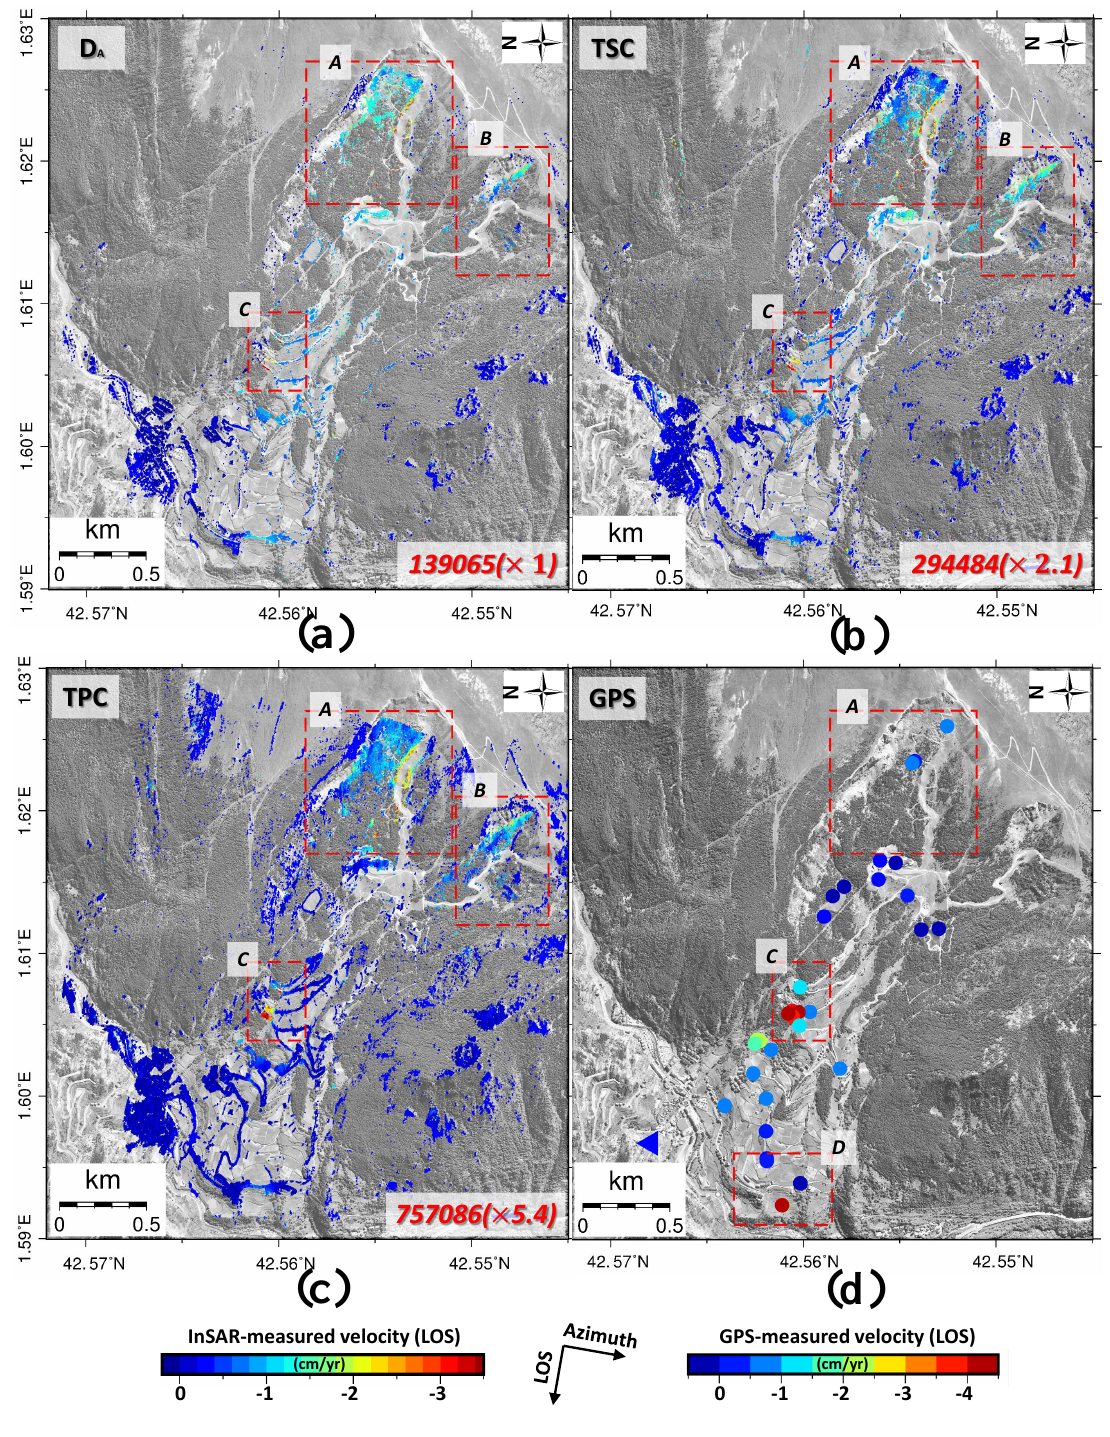
Figure 8. LOS displacement velocity maps derived by ( a ) D A , ( b ) TSC, ( c ) TPC and ( d ) GPS approaches, respectively. The filled blue triangle in ( d ), i.e., E1, indicates the location of the GPS base point. GPS displacements have been projected to LOS. The red rectangles highlight the areas zoomed in Figure 9. The red numbers at the right bottom corner of ( a – c ) represent the amount of valid pixels obtained by each